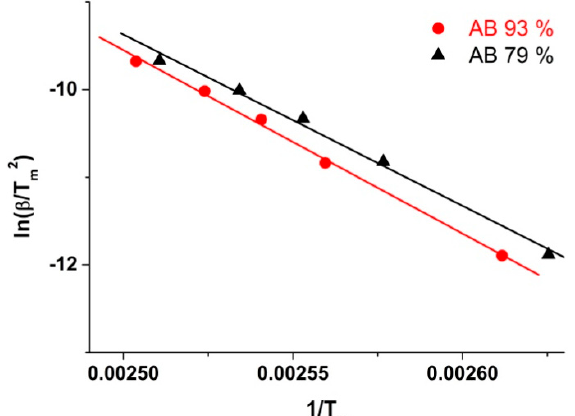
Figure 6. Linear dependencies in the coordinates of the Kissinger Equation (4) for samples of ammonia borane with different purities.